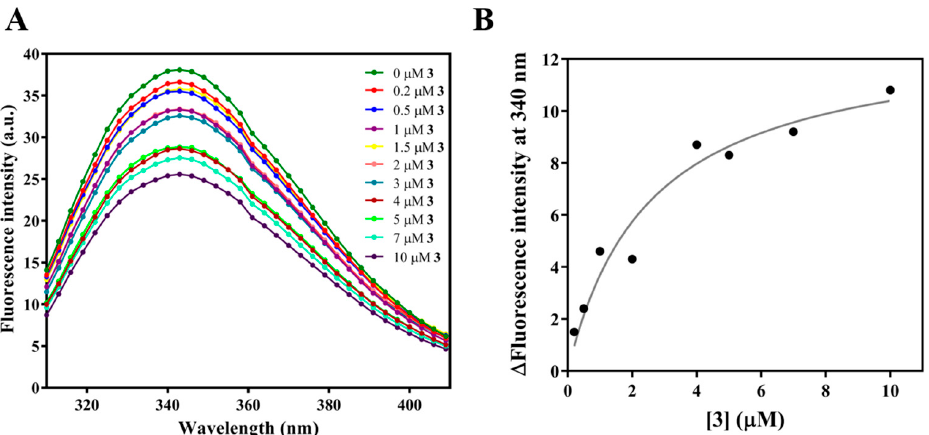
Figure 6. Compound 3 binds to FtsZ with strong affinity. ( A ) Representative spectra of tryptophan fluorescence of Streptococcus pneumoniae FtsZ ( Spn FtsZ) in the presence of increasing concentrations of 3 . Spn FtsZ was excited at 295 nm. ( B ) Three independent sets of experiments are represented in the plot of change in fluorescence intensity at 340 nm vs. concentration of 3 , which was used to determine the binding constant (K d ).